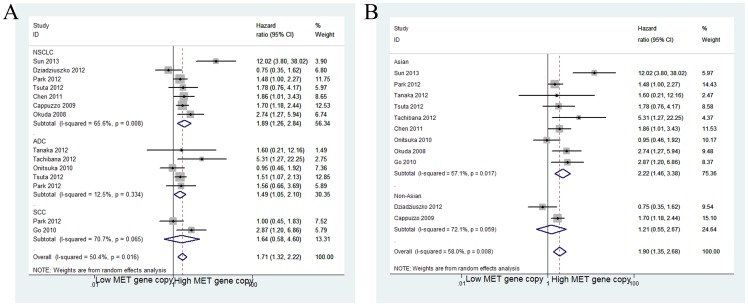
Forest plot (A) assessing MET gene copy number in NSCLC stratified by histological subtypes; Forest plot (B) assessing MET gene copy number in NSCLC stratified by ethnic source.